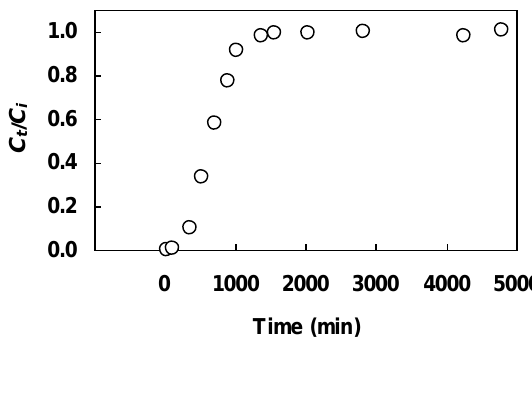
Figure 7. Experimental breakthrough curve for nickel biosorption on seaweed biomass; data of Borba et al.